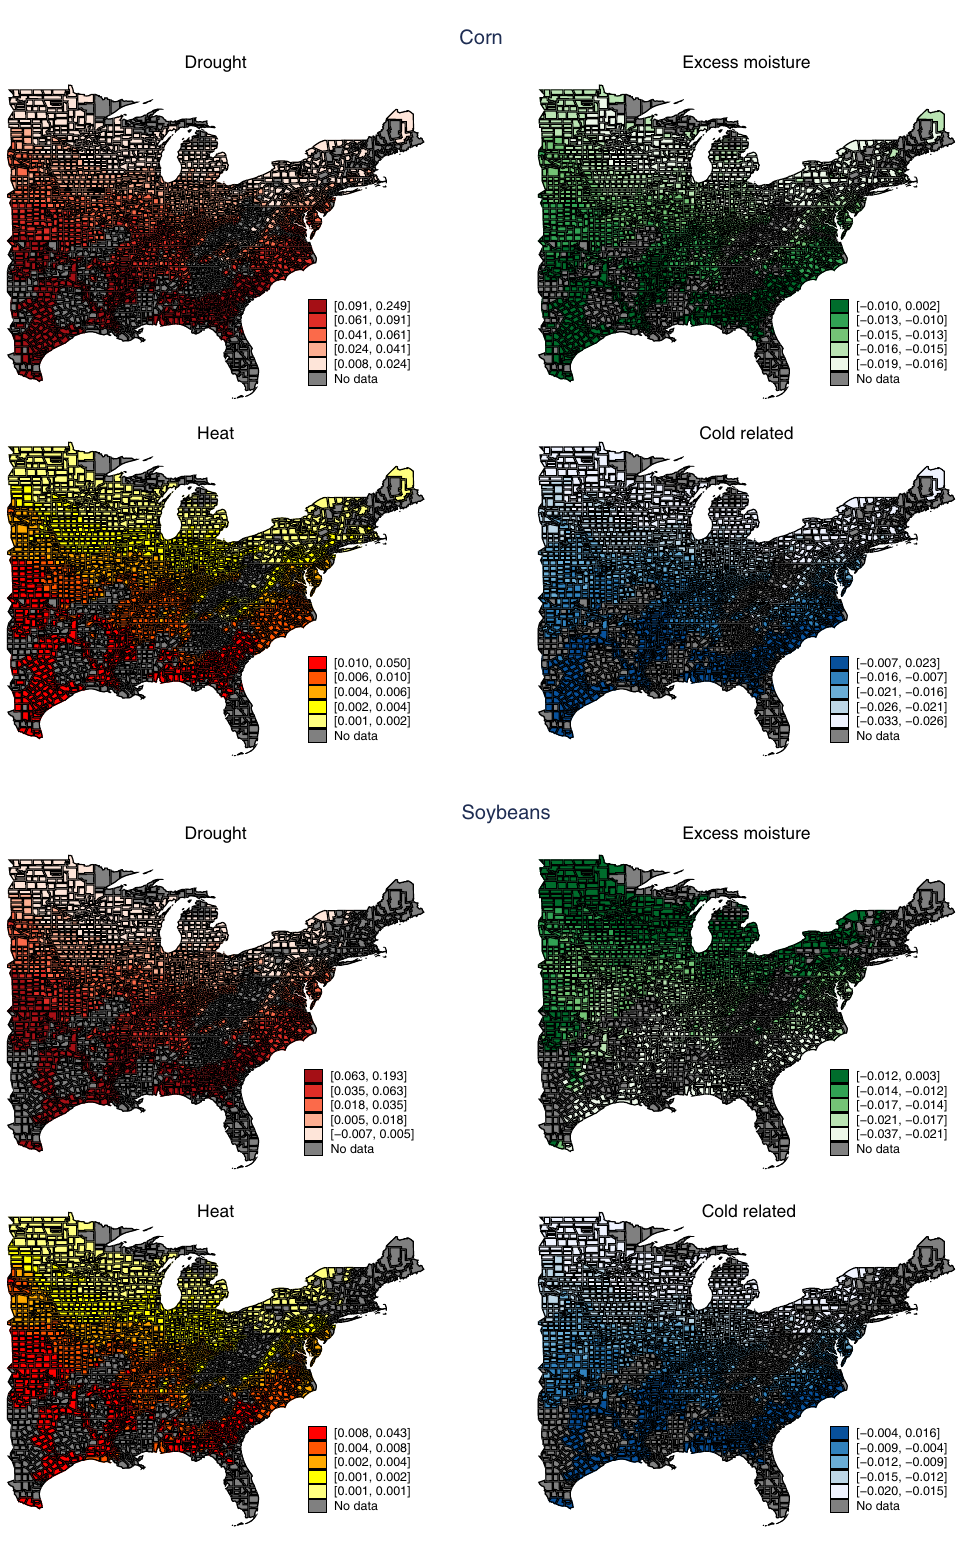
Fig. 5 Spatial distribution of 1 °C warming impact on the county average cause-speci fi c loss – cost ratio (LCR), 1989 – 2014 ( N = 30,261 for corn and N = 29,014 for soybeans). For the uniform 1 °C warming scenario, the predictions are based on the estimated coef fi cients of the four cause-speci fi c LCR models (assuming no precipitation changes). The darker colors represent greater impacts on the average